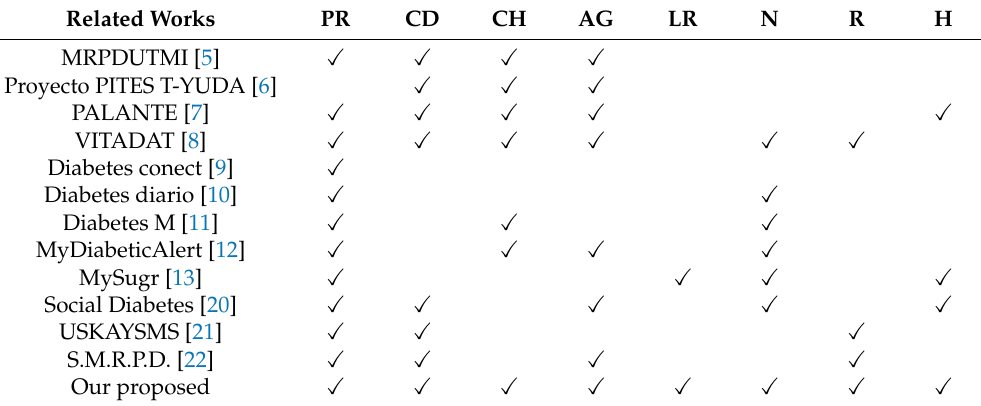
Table 12. Telemonitoring system